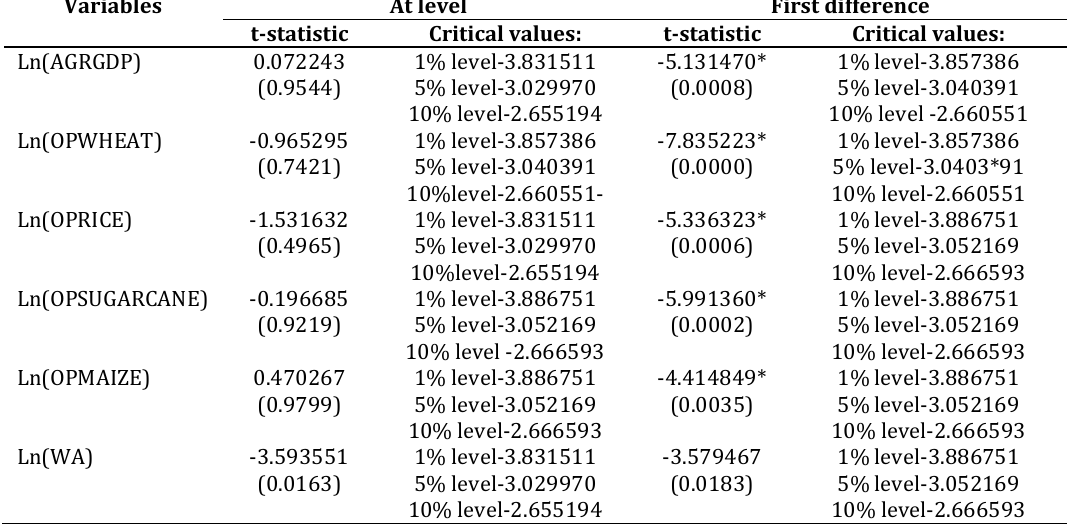
Table 1: Results of ADF unit root test including (trend and intercept) Variables At level First difference t-statistic Critical values: t-statistic Critical